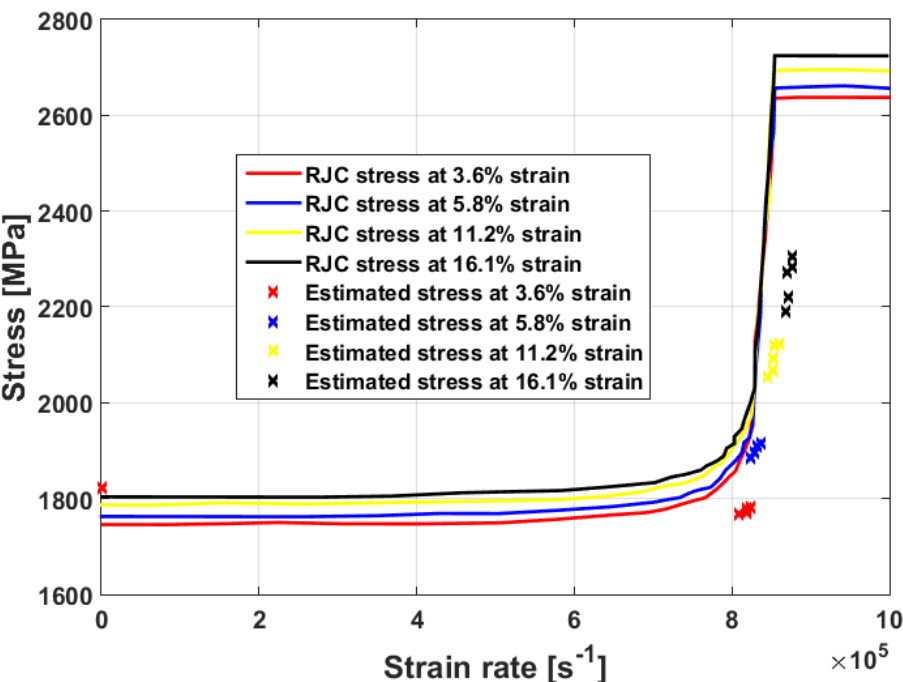
Figure 10. Predicted stresses obtained using the modified JC (RJC) model that was presented by Rule and Jones [68] compared to yield strength in the quasi-static experiment and anticipated from a one-dimensional Taylor specimen model at very high strain rates.